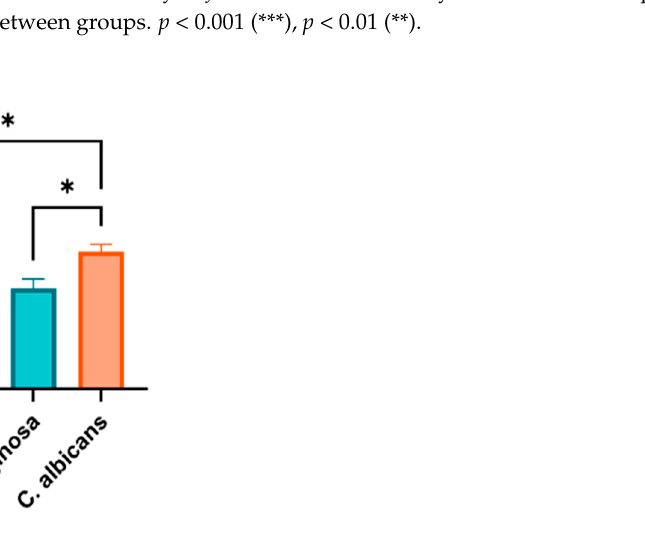
Figure 7. Activity of AgNPs fabricated by A. arabica gum. One-way ANOVA with was performed to identify differences between groups. p < 0.01 (**), p < 0.05 (*).